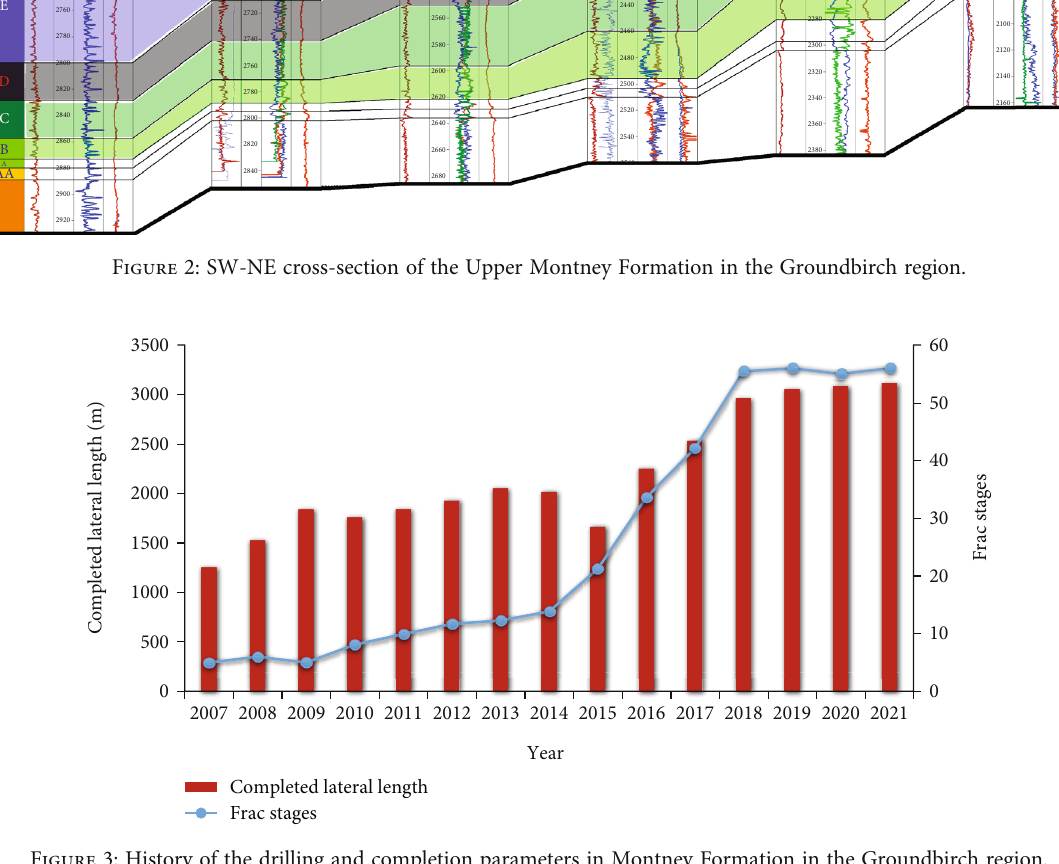
Figure 3: History of the drilling and completion parameters in Montney Formation in the Groundbirch